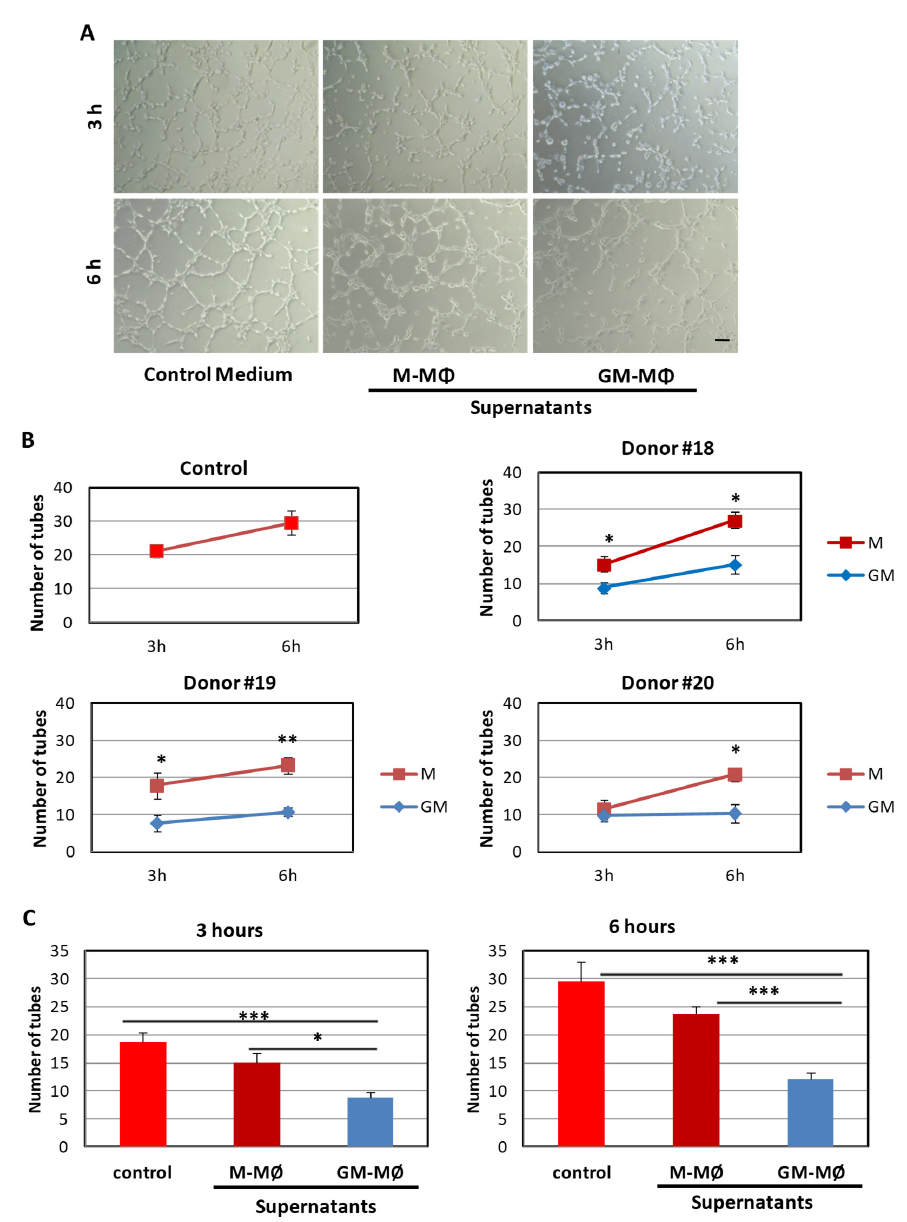
Figure 1. E ff ect of GM-M Φ and M-M Φ supernatants on tubulogenesis. Matrigel was mixed (at 1:1 dilution) with control medium or macrophage (M Φ ) supernatants from three di ff erent donors (#18, #19, and #20), and the mixture was added to plates and incubated for 1 h. Then, human umbilical vein-derived endothelial cells (HUVECs) in vascular endothelial growth factor (VEGF)-enriched EBM2 / EGM2 medium were added to Matrigel plates and incubated for the times indicated at 37 ◦ C. The cord network formation was visualized by taking pictures at 3 h and 6 h after cell plating and representative images are shown ( A ). The appearance of an almost complete network is achieved by 6 h in cells incubated with control medium or cells treated with M-M Φ supernatants; while in the presence of GM-M Φ supernatants, open tubules with some patches of disorganized and sparse cells are observed. Scale bar: 100 μ m. The number of closed tubes in the network was quantified and representative assays of more than three different experiments per condition are shown ( B ). The mean number of closed tubes, representing all the experiments ( n = 6), is shown by histograms ( C ). Statistical significance was calculated with one way ANOVA and data are presented as mean ± SEM. (* p < 0.05; ** p < 0.01; *** p <